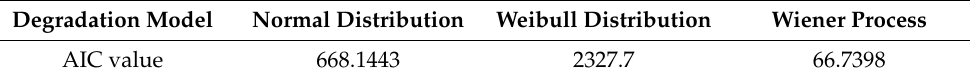
Table 2. AIC value of each degradation model based on previous data. Degradation